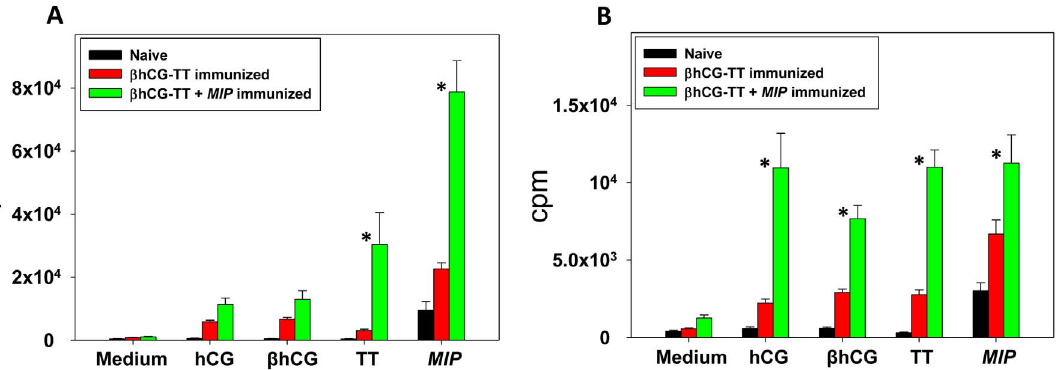
Figure 3. Proliferative T cell recall responses. In vitro proliferative responses to hCG, b hCG, TT or MIP of splenocytes derived from naive, b hCG- TT or b hCG-TT + MIP immunized (A) BALB/c and (B) C57BL/6 mice. Bars represent arithmetic mean 6 standard error. *p # 0.05 versus vs animals immunized with b hCG-TT. n=6.